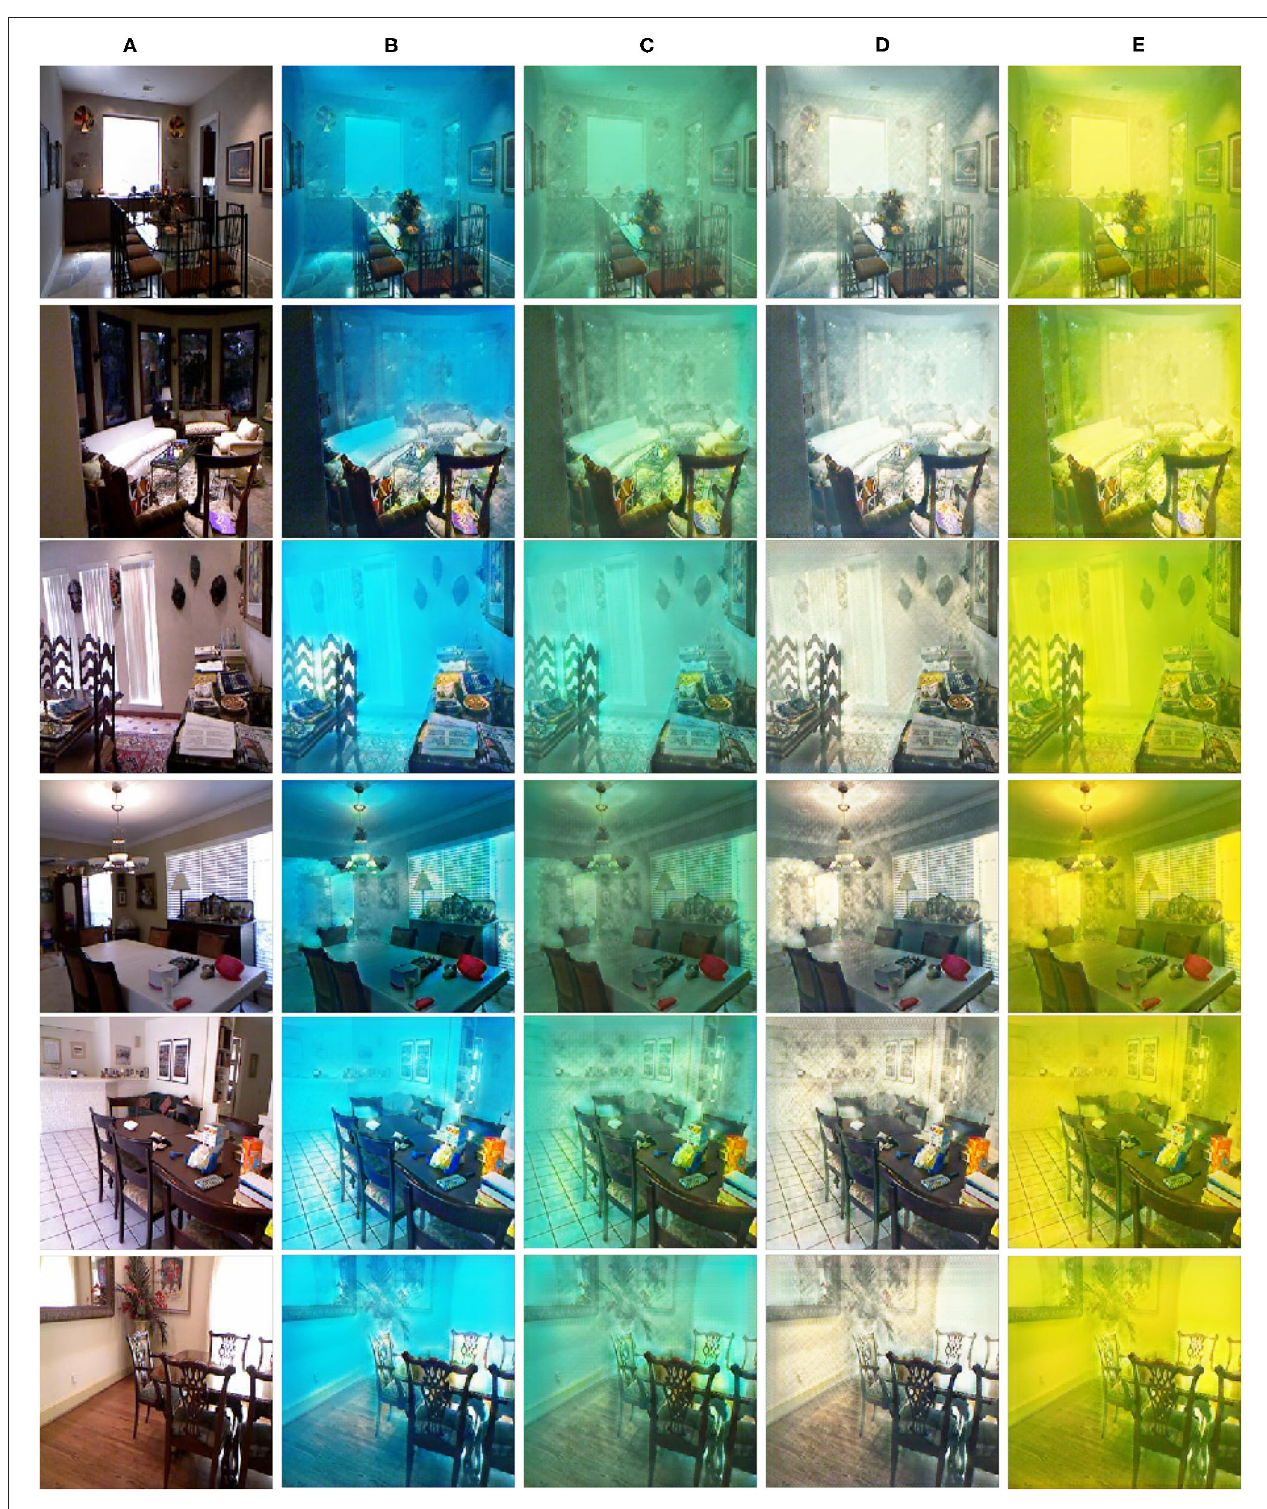
FIGURE 8 | Sample results for the synthesis of underwater images. (A) Show in-air images. (B–E) Represent blue style, green style, white style and yellow style, respectively.